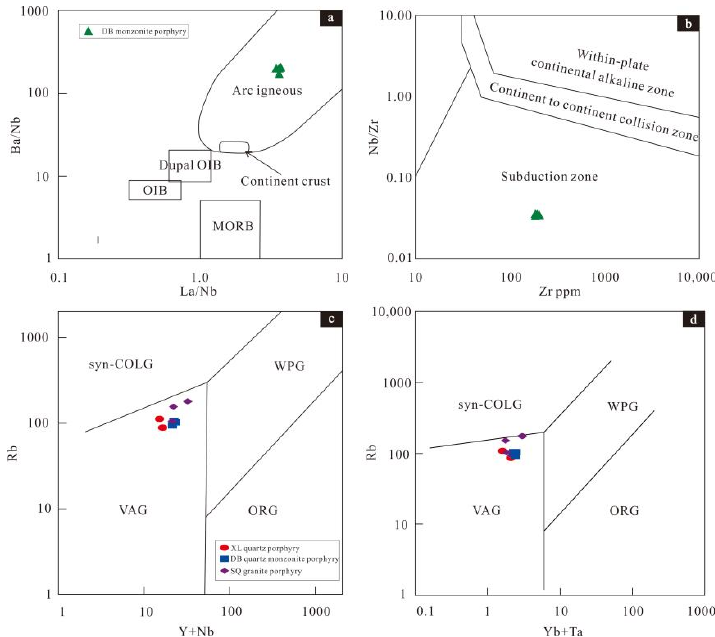
Figure 12. Tectonic discrimination diagrams for the Early Cretaceous intrusive rocks. ( a ) (La/Nb) versus (Ba/Nb) diagram (Jahn et al. [150]); ( b ) Zr versus (Nb/Zr) diagram (Luchitskaya et al. [151]); ( c ) (Y + Nb) versus Rb diagram (Pearce et al. [152]); ( d ) (Yb + Ta) versus Rb diagram (Pearce et al. [152]). Abbreviations: VAG: volcanic arc granite; Syn COLG: syn-collisional granite; WPG: within-plate granite; ORG: ocean ridge granite.